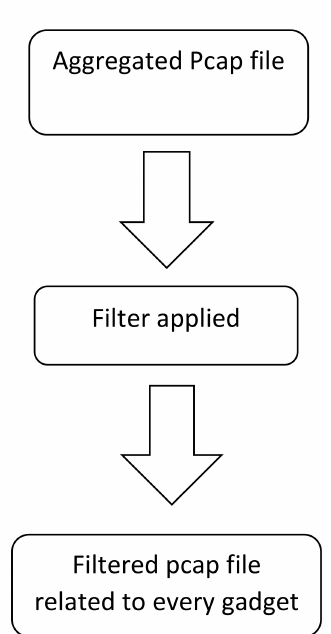
Figure 2. PCAP filtering missing value